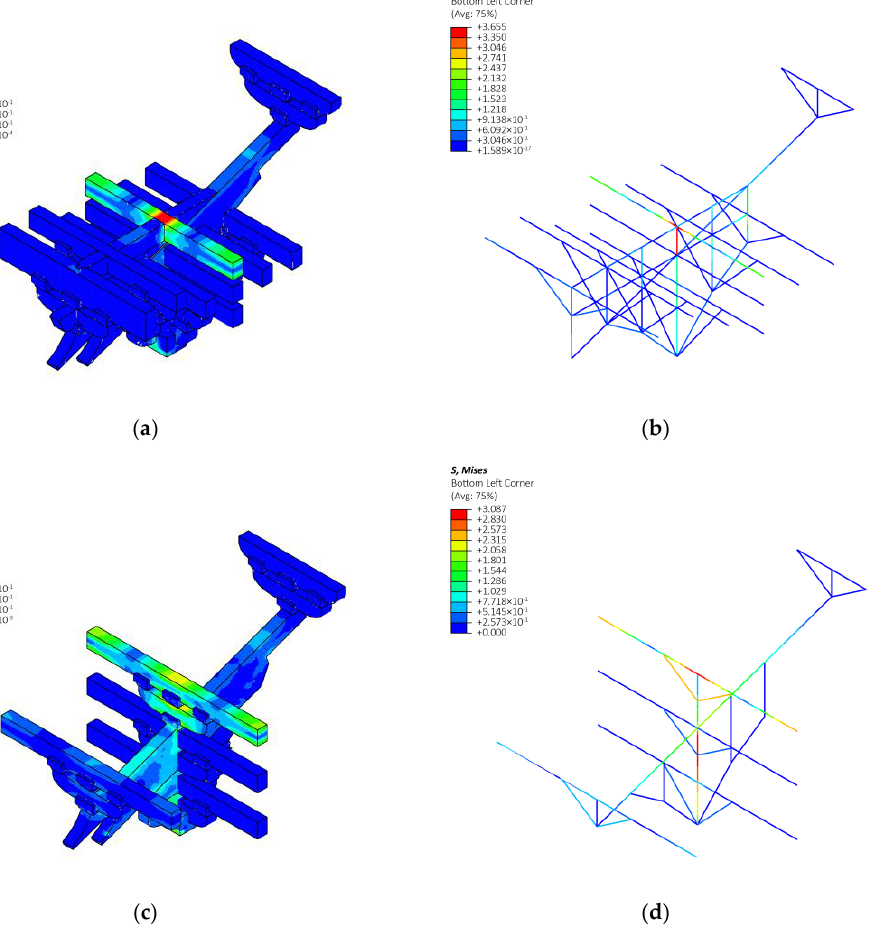
Figure 15. Mises stress of the Dou-gongs bearing the roof load, refined model vs. simplified model (unit: MPa): ( a ) refined model, Ji-xin-zao Dou-gong; ( b ) simplified model, Ji-xin-zao Dou-gong; ( c ) refined model, Tou-xin-zao Dou-gong; ( d ) simplified model, Tou-xin-zao Dou-gong.